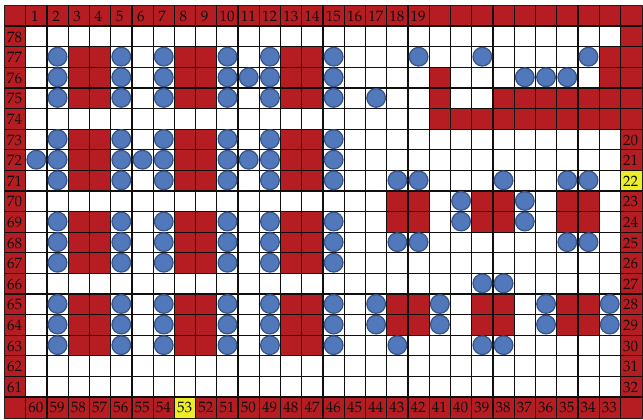
Figure 12: A restaurant with 18 tables and 109 persons.